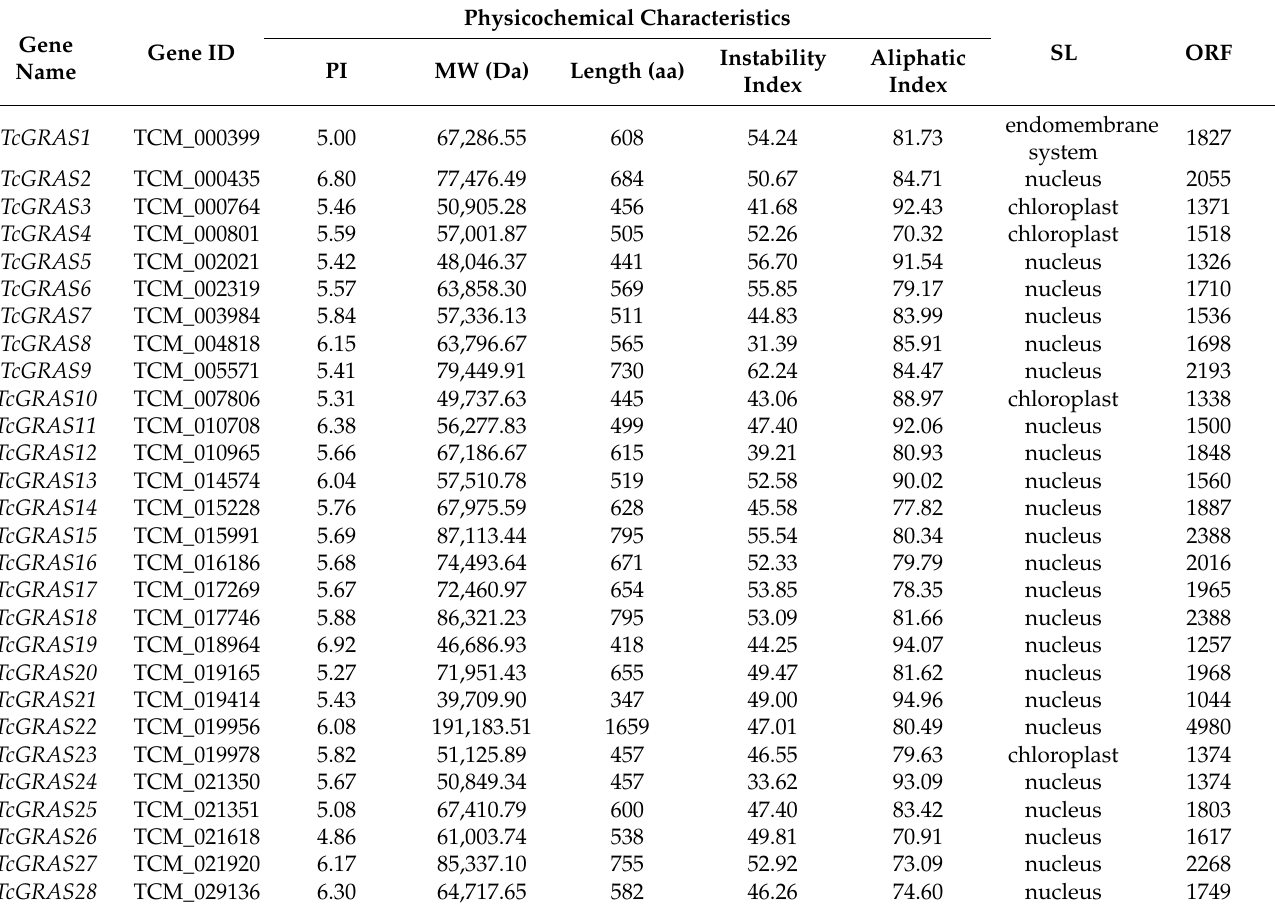
Table 2. Physicochemical properties and subcellular localization analyses of the GRAS gene family in T. cacao